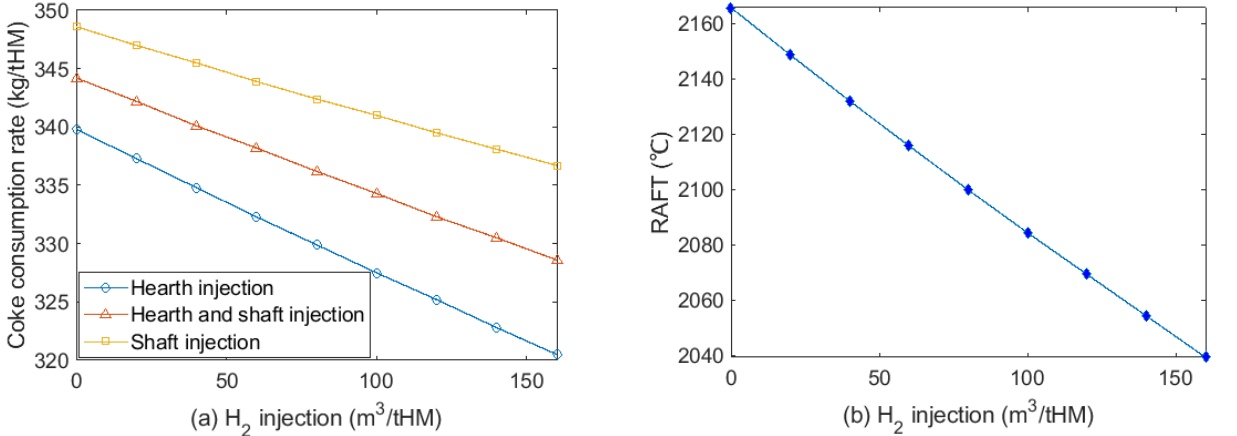
Figure 6. ( a ) Coke consumption rate at different H 2 injection volumes at different injection positions; ( b ) effect of H 2 injection to hearth on RAFT at 9% oxygen enrichment rate. The effect of H 2 injection on RAFT at a constant oxygen enrichment rate is shown in Figure 6b. Injecting 20 m 3 /tHM H 2 can reduce RAFT by around 16 ° C . Increasing oxygen enrichment can achieve thermal compensation to maintain a stable RAFT and reduce coke consumption, as shown in Figure 7. Compared to the cases without thermal com- pensation, further reduction in coke consumption is obtained at 309 kg/tHM with 12.4% oxygen enrichment at 160 m 3 /tHM H 2 injection.